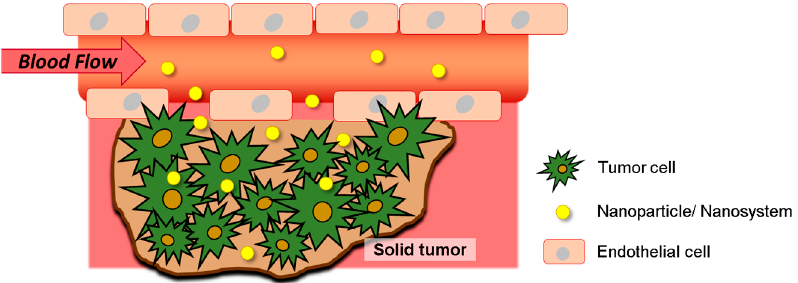
Figure 3. Illustration of the accumulation of nanosystems at tumor sites through an enhanced permeation and retention (EPR) effect.